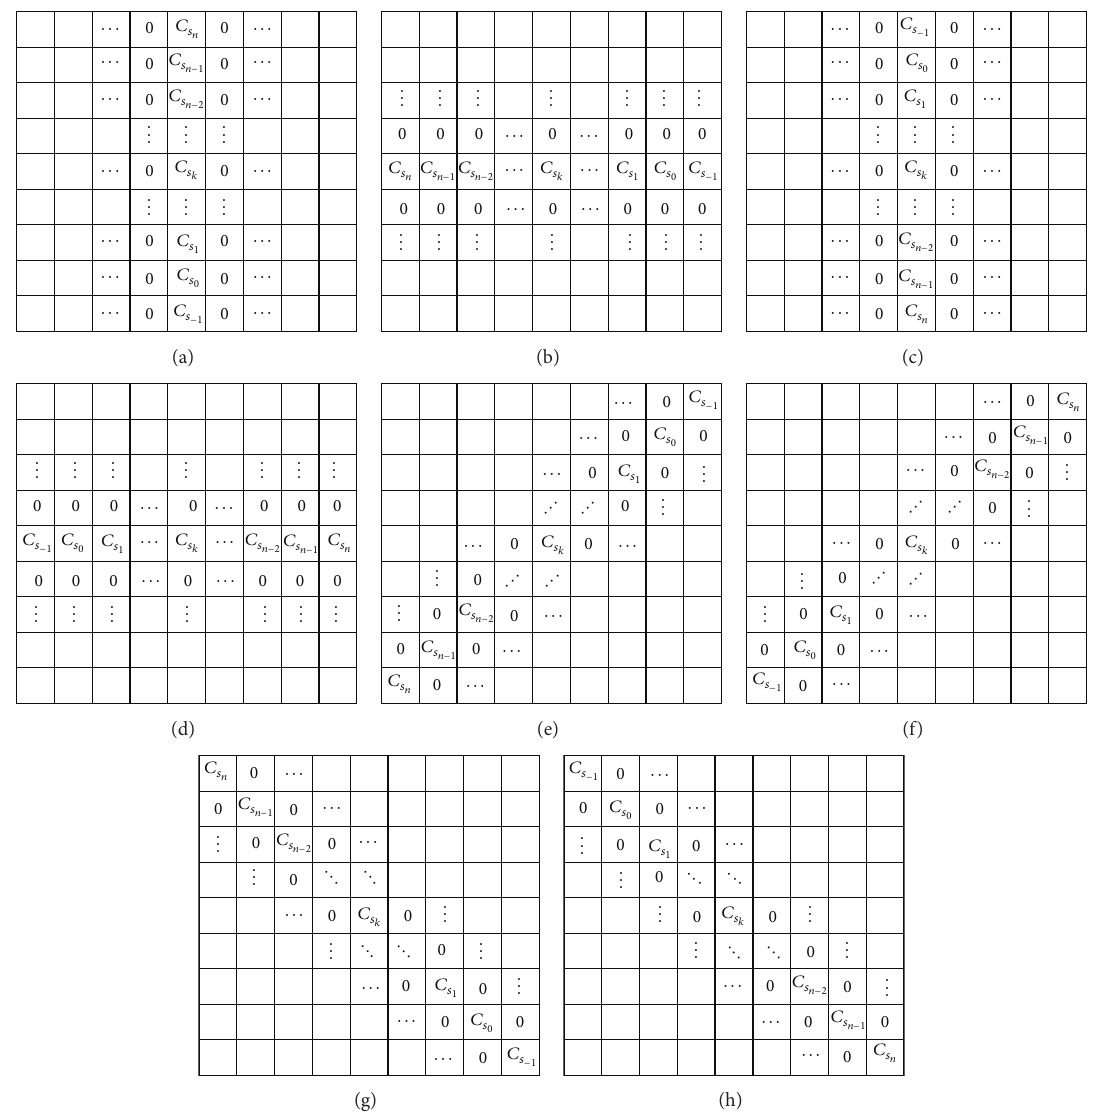
Figure 3: Fractional differential masks 𝐷 V , respectively, on the eight directions. (a) Fractional differential operator on 𝑥 -coordinate negative direction, noted as 𝐷 V 𝑥− . (b) Fractional differential operator on 𝑦 -coordinate negative direction, noted as 𝐷 V 𝑦− . (c) Fractional differential operator on 𝑥 -coordinate positive direction, noted as 𝐷 V 𝑥+ . (d) Fractional differential operator on 𝑦 -coordinate positive direction, noted . (f) Fractional differential operator on right upward as 𝐷 V 𝑦+ . (e) Fractional differential operator on left downward diagonal, noted as 𝐷 V ldd diagonal, noted as 𝐷 V . (g) Fractional differential operator on left upward diagonal, noted as 𝐷 V . (h) Fractional differential operator on rud lud right downward diagonal, noted as 𝐷 V rdd